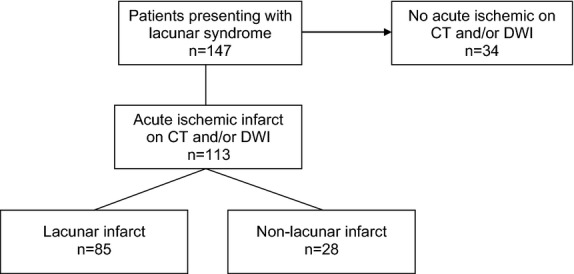
Enrolment diagram.